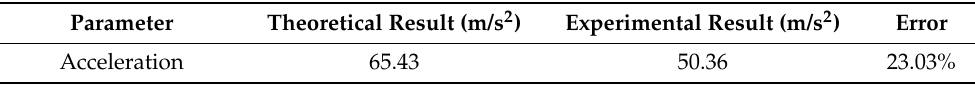
Table 5. The comparison between the theoretical and experimental